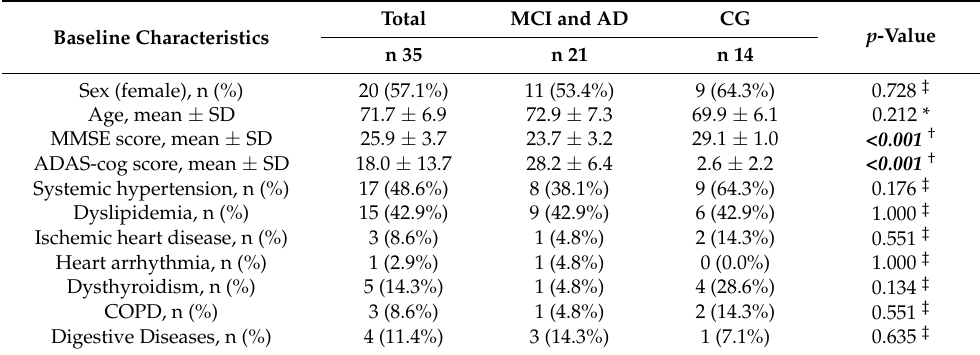
Table 1. Demographics and clinical characteristics of enrolled patients.